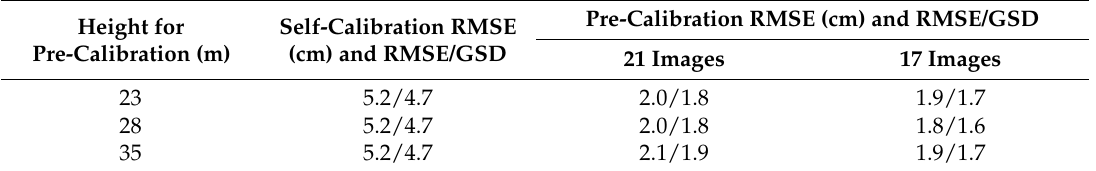
Table 11. The residuals of 2 CPs resulted after BBA process for an oblique flight when using self ‐